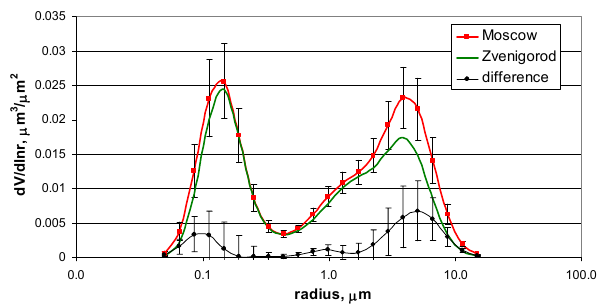
Fig.7. Mean aerosol volume size distribution dV/dlnr in Moscow and the difference in dV/dlnr Fig. 7. Mean aerosol volume size distribution dV / d ln r in Moscow between Moscow and Zvenigorod. n=112. and the difference in dV / d ln r between Moscow and Zvenigorod. n